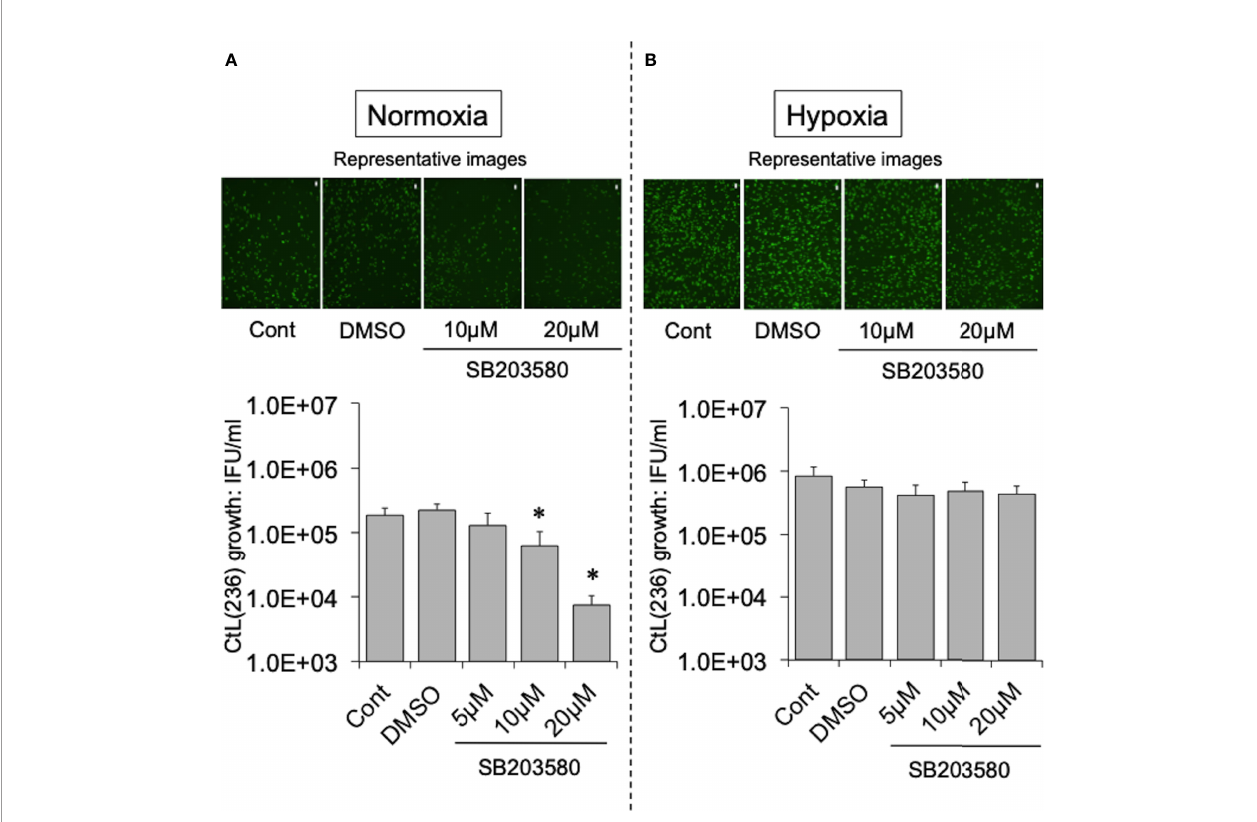
FIGURE 3 | Effect of NOX4-downstream molecule p38MAPK-speci fi c inhibitor SB203580 on the intracellular growth of GFP-expressing CtL2 (236) under normoxia (A) and hypoxia (B) . The HEp-2 cells were infected at MOI = 5 with GFP-expressing CtL2 (236) in the presence or absence of the drug, and cultured for 48 h. Representative images show inclusion bodies (green) formed in infected HEp-2 cells. Bars = 200 m m. The number of bacteria was calculated by IFU assay of infected cells cultured for 48 h. Data show means ± SD obtained from at least three experiments. * p < 0.05 vs. the value of each control